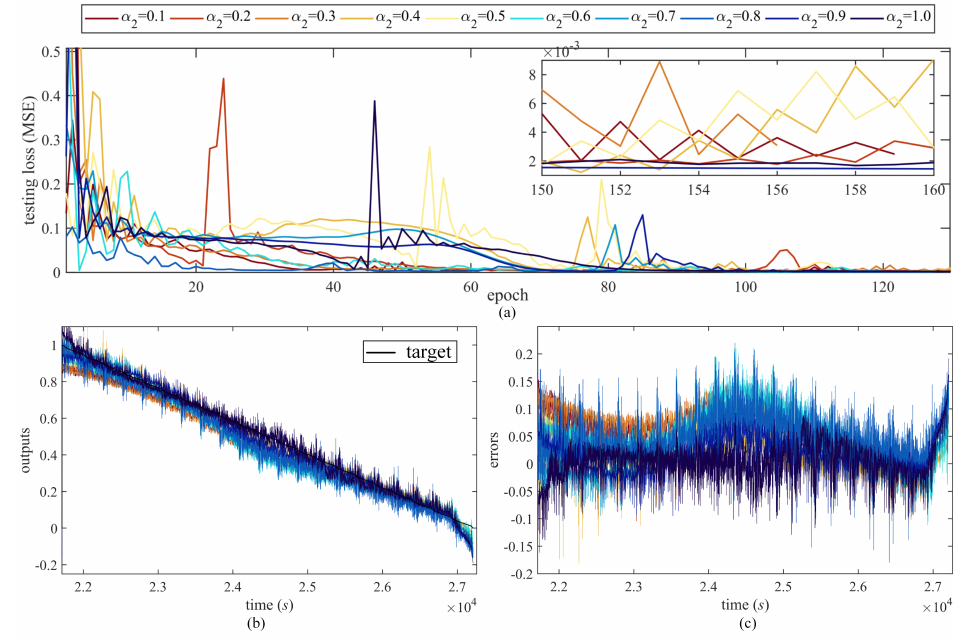
Figure 11. Sensitivity of the fractional order α 2 in PDE constraint encoded into loss function,